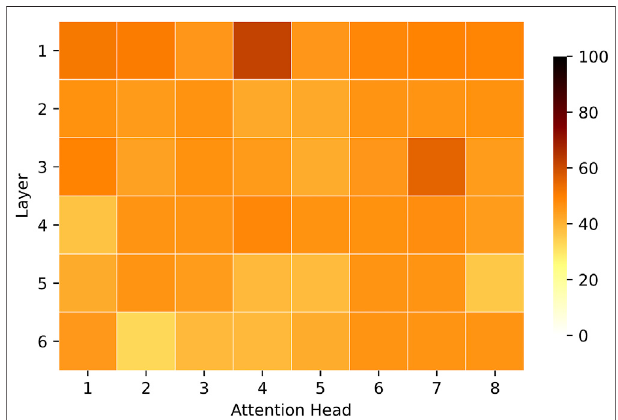
FIGURE 3 | For every attention head, we show the proportion (in %) of attention links between objects in the same semantic cluster vs all attention linksdisregardingthecluster.Theresultsareaveragedacrossallimagesinthe test set. Attention heads and layers are shown in horizontal and vertical axes accordingly. The darker the colour, the larger the ratio. The colour scale on the right indicates the range of attention proportions (minimum is 0, maximum is